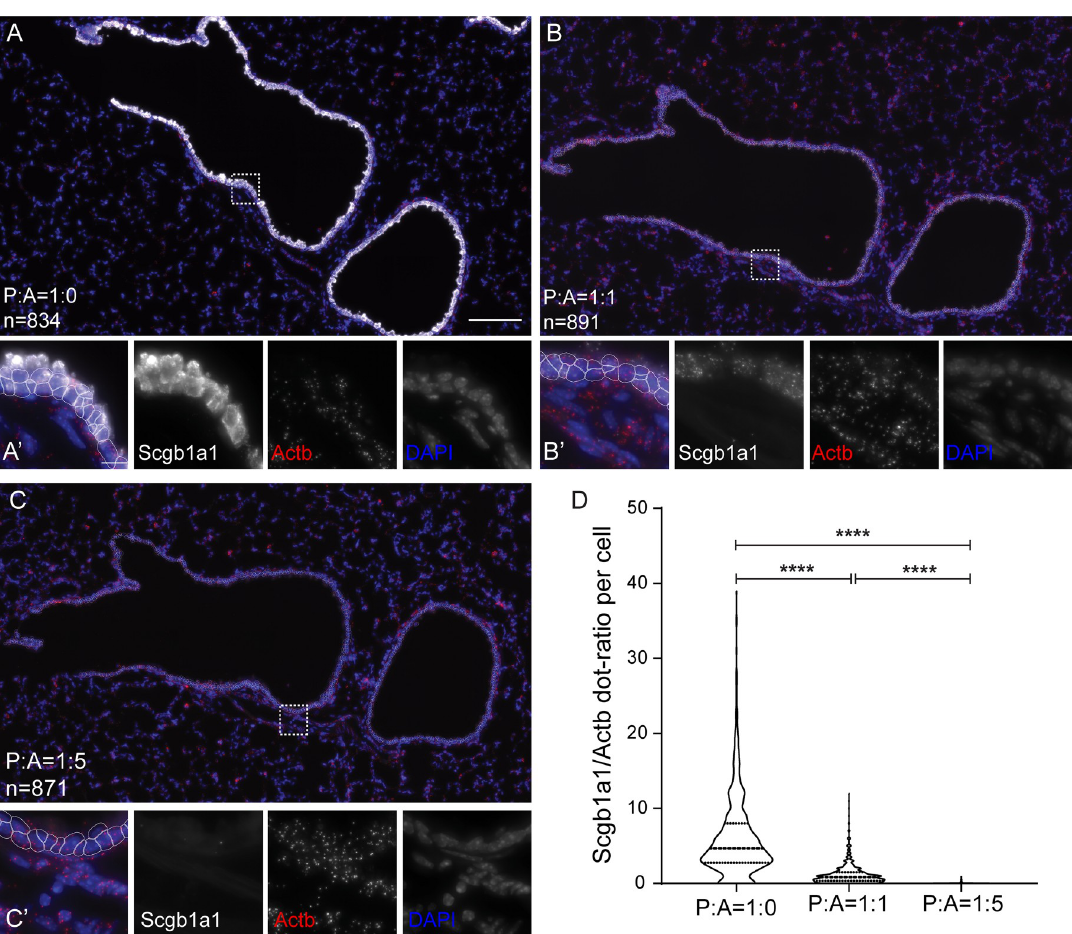
Fig 3. Concentration-dependent SCRINSHOT detection efficiency. (A-C) Representative images of SCRINSHOT signals for Scgb1a1 padlock probes in the absence or presence of an antisense competitor oligo, targeting the binding site of Scgb1a1 padlock probe. SCRINSHOT signal for Scgb1a1 padlock probe in the absence of the antisense competitor oligo (A), when mixed in equal concentration with the antisense competitor oligo (B) and when mixed with 5 times higher concentration of the antisense competitor oligo (C). (A’- C’) Magnified areas of the indicated positions (square brackets) of images A-C. (D) Violin plot of the Scgb1a1 and Actb signal dots ratio in all airway cells of the 3 compared conditions. Scale bars in (A-C) is 100 μ m and (A’-C’) is 10 μ m. All analyses were done using